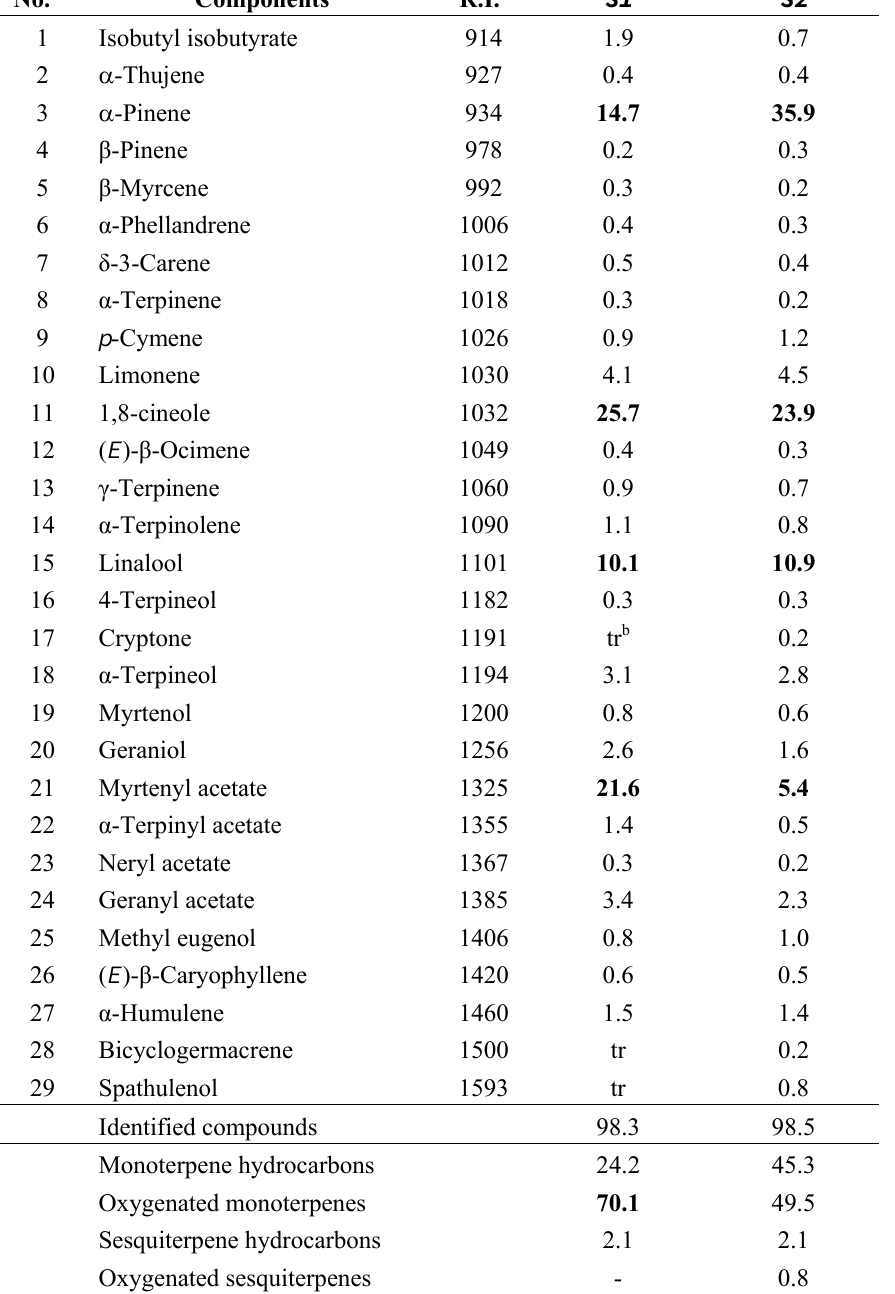
Table 1. Chemical composition (%) of Myrtus communis essential oil collected from two localities of the Montenegro coastline: Ulcinj ( S1 ) and Herceg Novi ( S2